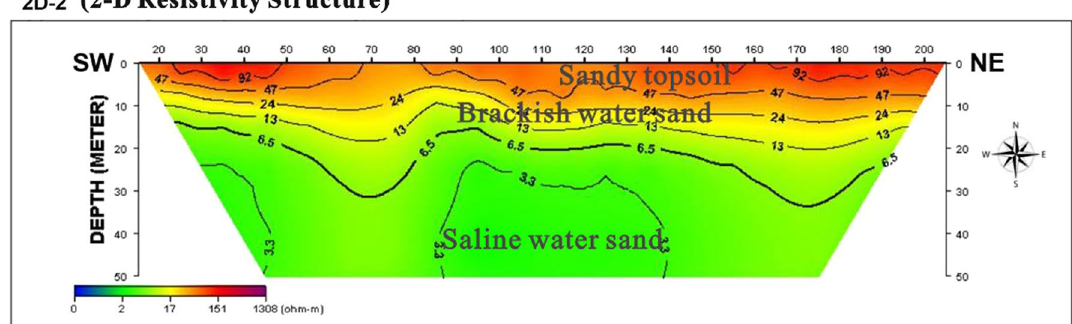
Fig. 6 Resistivity imaging of Traverse 2D-2